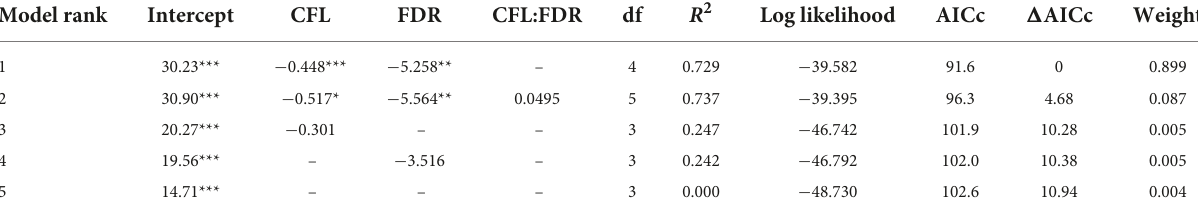
TABLE 3 Model selection table that outlines the effects of capture fuel load (CFL) and fuel deposition rate (FDR) on minimal stopover duration. Model